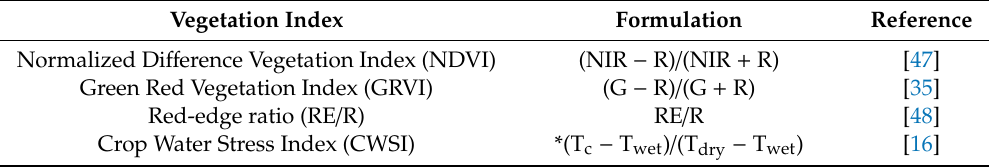
Table 3. Indices calculated in the study for cotton water status monitoring obtained from UAS imagery. The band centres used in this study for computing the multispectral indices were 475, 560, 668, 717 and 840 nm for the blue, (B), green (G), red (R), red-edge (RE) and near infrared (NIR) bands, respectively. Vegetation Index Formulation Reference Normalized Di ff erence Vegetation Index